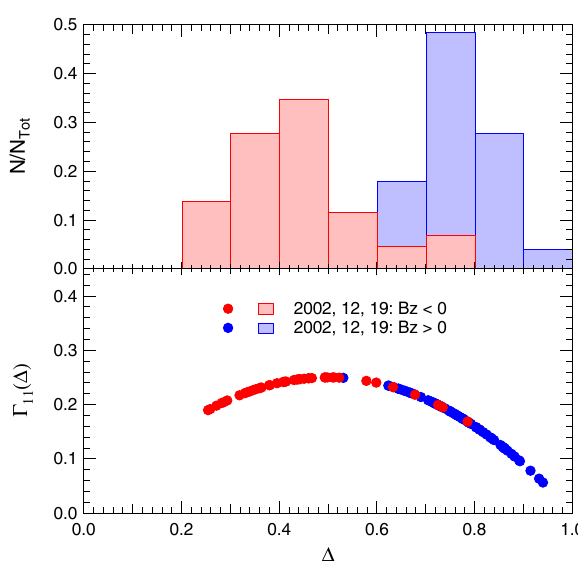
Fig. 5. Upper Panel: normalised histograms of the normalised disorder degree Δ , in 0.1 bins, for the December 19th, 2002, 06:00 – 10:00 UT interval; red and blue cityscapes correspond to negative and positive IMF B z scans, respectively. Values have been normalised to the total number of scans for each B z polarity (69 and 46 for positive and negative values, respectively). Lower panel: second order complexity measure Γ 11 as a function of the normalised disorder degree Δ for same time interval. Fig. 6. February 2002: (cid:2) Δ (cid:3) (upper panel) and (cid:2) Γ 11 (cid:3) (lower panel) as functions of B y and B z . The color scale for each function is displayed on the right of each panel.